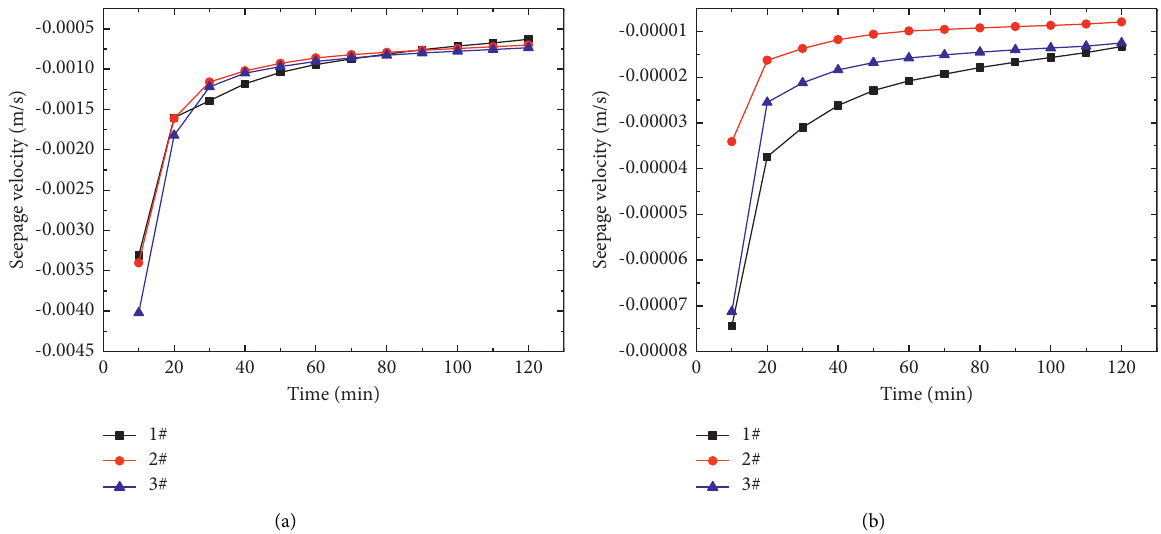
Figure 26: Infiltration velocity at observation points 1–3 of (a) building 1 and (b) buildings 2–4 with seepage wells placed around building 1 in the numerical model.